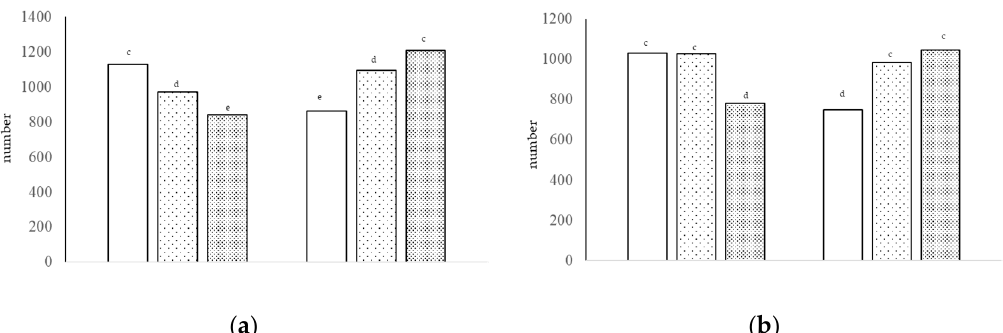
Figure 3. Number of sulfated acid cells [( a ), interaction of growth promoter and type of diet, c–e p < 0.01; SEM = 76.253] and number of non-sulfated acid cells [( b ), interaction of growth promoter and type of diet, c,d p < 0.01; SEM = 71.298] in the jejunum at day